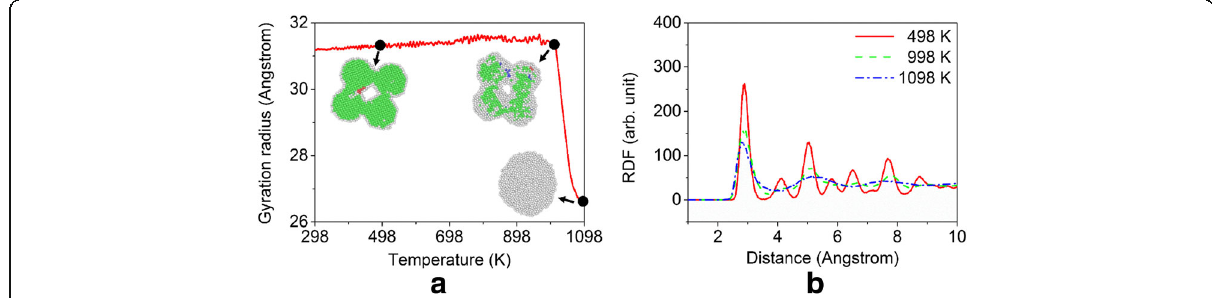
Fig. 3 Evolution of the gyration radius and radial distribution function during the heating process. a Gyration radius as a function of temperature during the heating process, in which the insets show the corresponding sectional view of the nanostructures at 498, 998, and 1098 K. b The corresponding radial distribution functions (RDF) of the system at 498, 998, and 1098 K